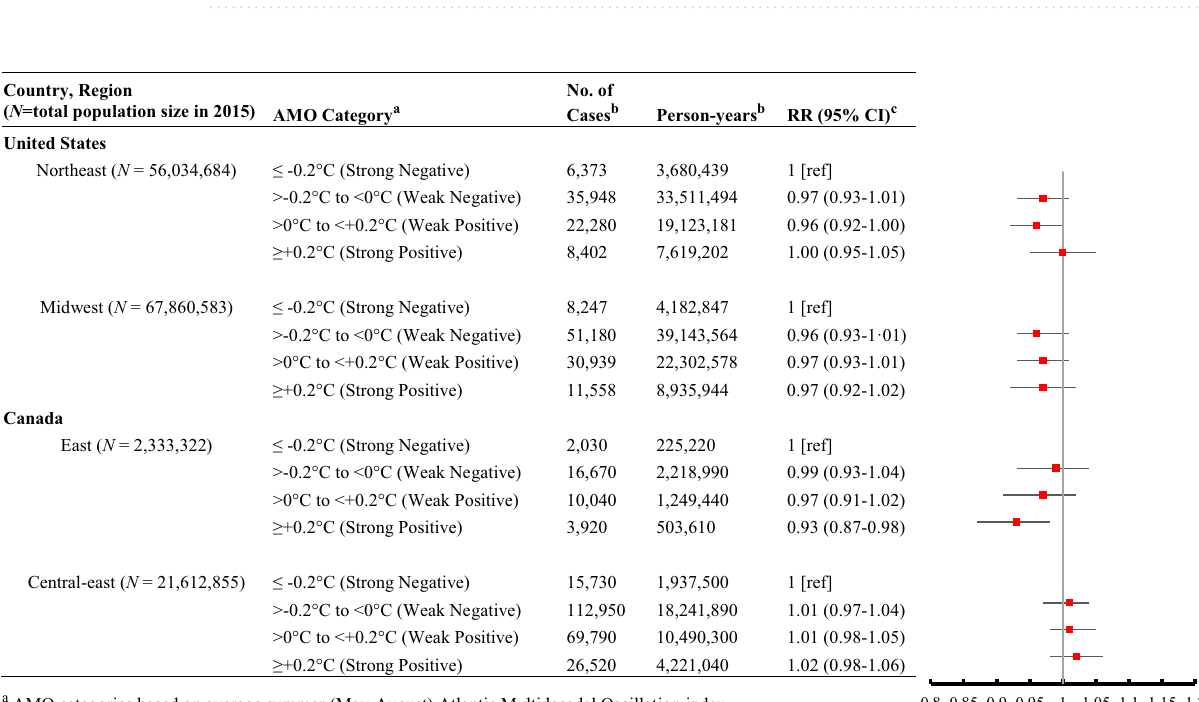
Figure 2. Association between ENSO categories and acute myocardial infarction-related mortality (United States) and admission (Canada) rates for older adults, 2000–2015.